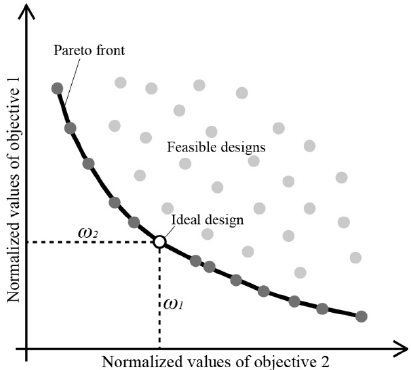
Figure 8. Identifying the ideal design from the Pareto front based on the WSM.